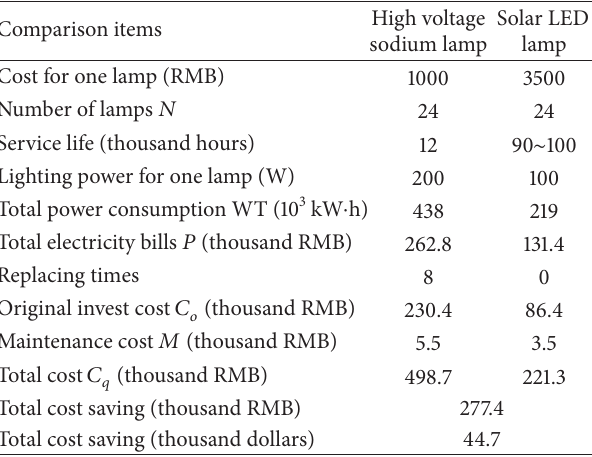
Table 4: The comparison of high voltage sodium lamp and solar LED lamp within the life cycle of 25